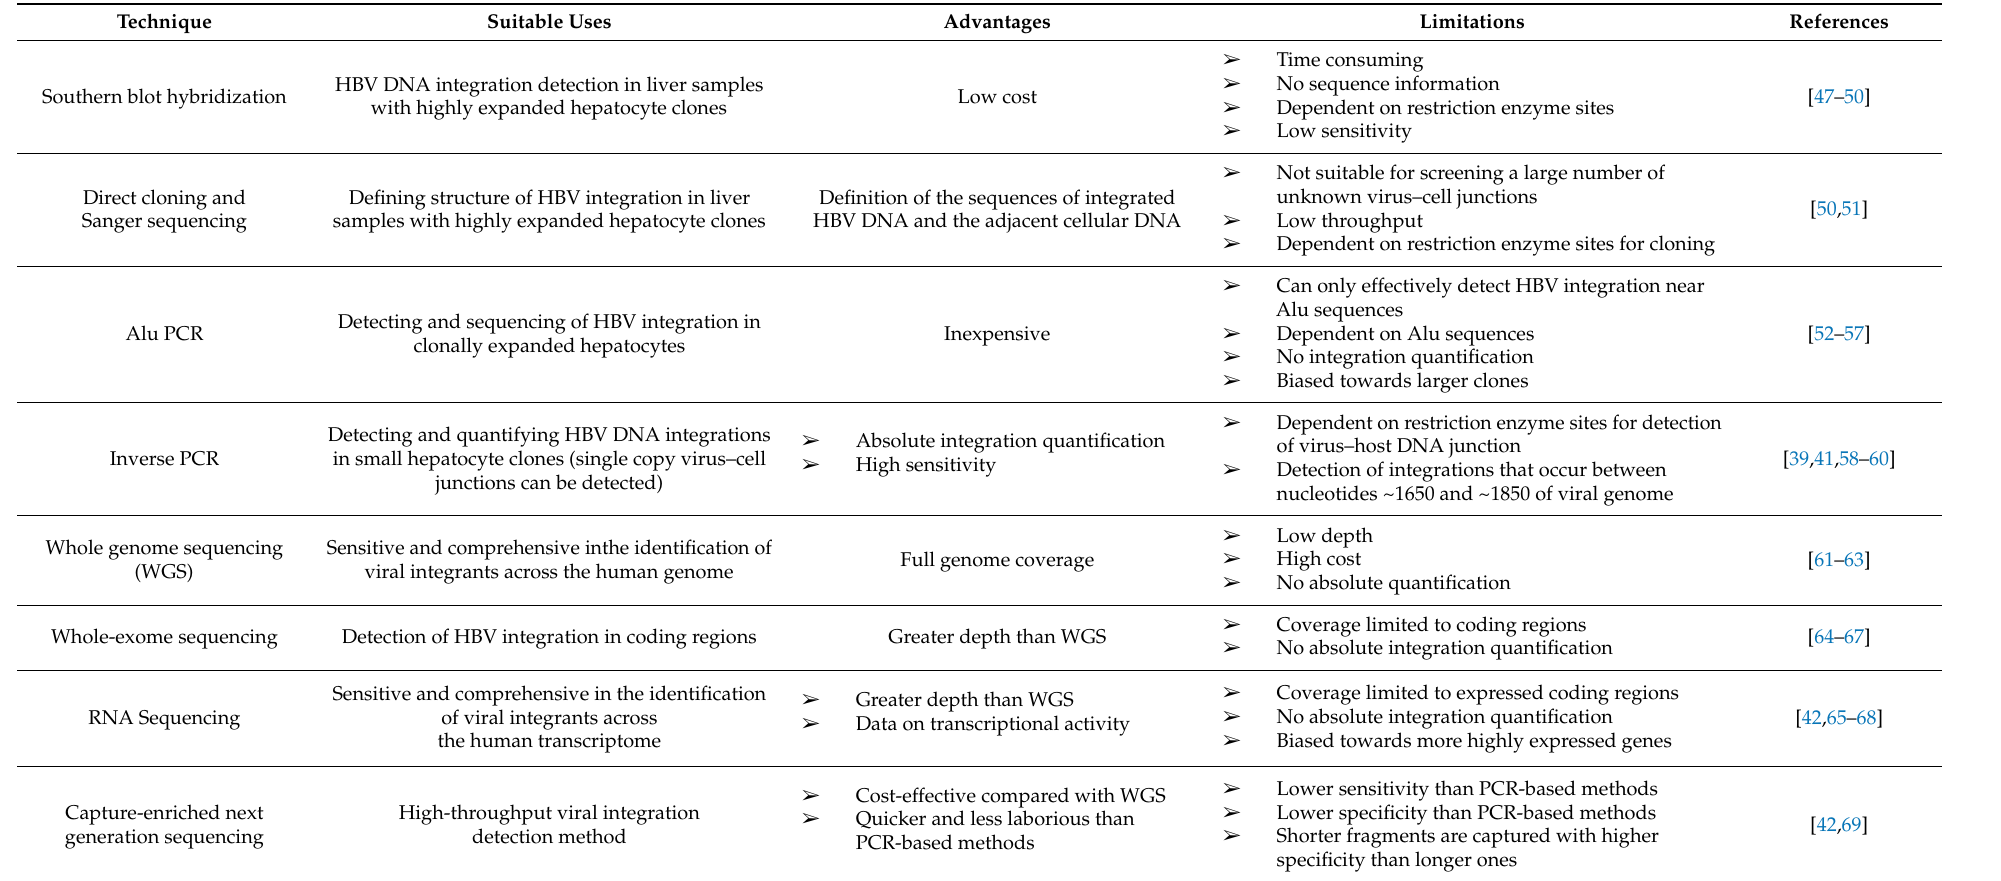
Table 1. Detection methods for HBV DNA